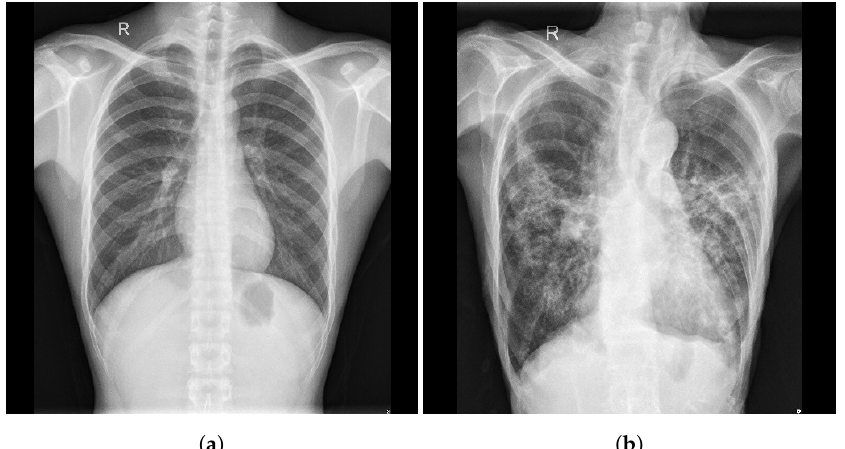
Figure 11. Examples of SHENZHEN images. ( a ) Normal patient; ( b ) patient with tuberculosis